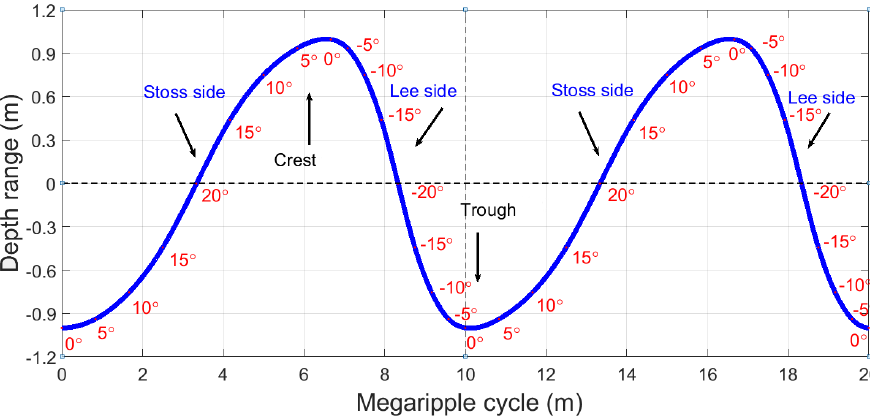
Figure 4. Schematic structure of a megaripple; wavelength is 10 m and depth variation is ∼ 1 m. Also indicated are crest versus trough area and stoss versus lee sides. Slopes of the megaripple are presented with a bin size of 5